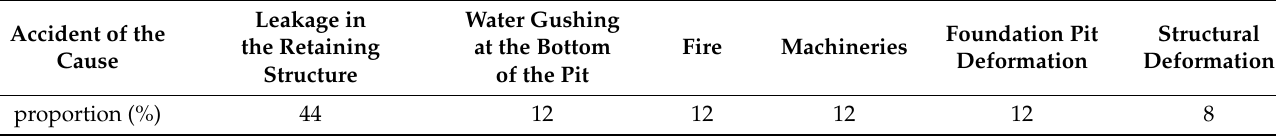
Table 2. Investigation form for causes of underground engineering accidents